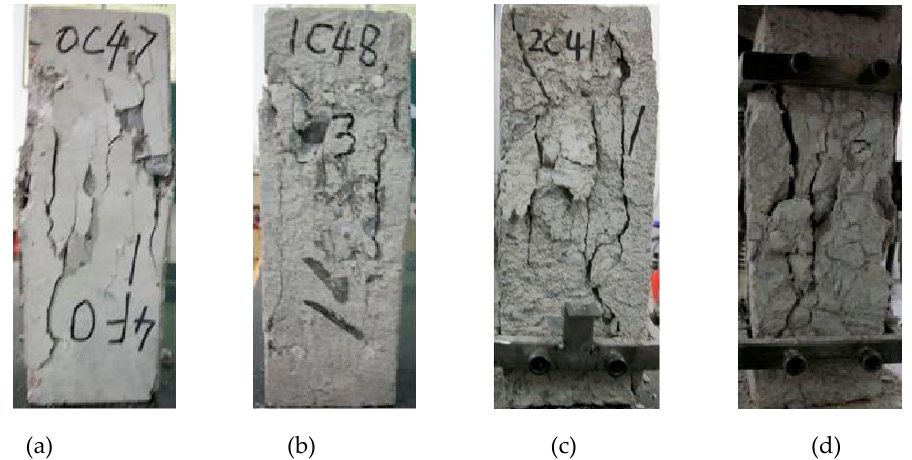
Figure 9. Failure mode of O-C40 concrete under uniaxial compression: ( a ) 0; ( b ) 50; ( c ) 100; ( d ) 150; 0, 50, 100, and 150 are numbers of freeze–thaw cycles.